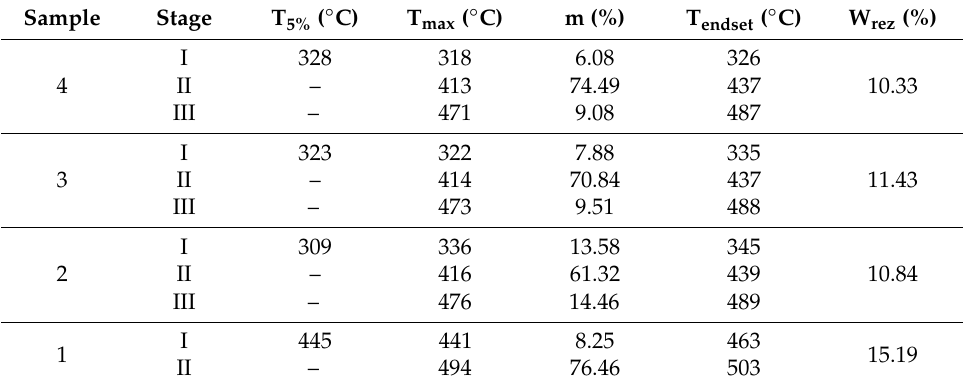
Table 2. Table 2. Data evaluated from TGA measurements.